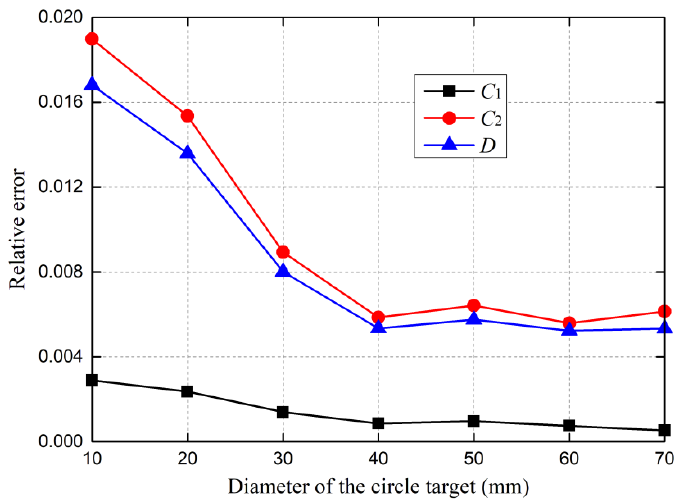
Figure 9. Influence of the circular target diameter on the calibration accuracy.